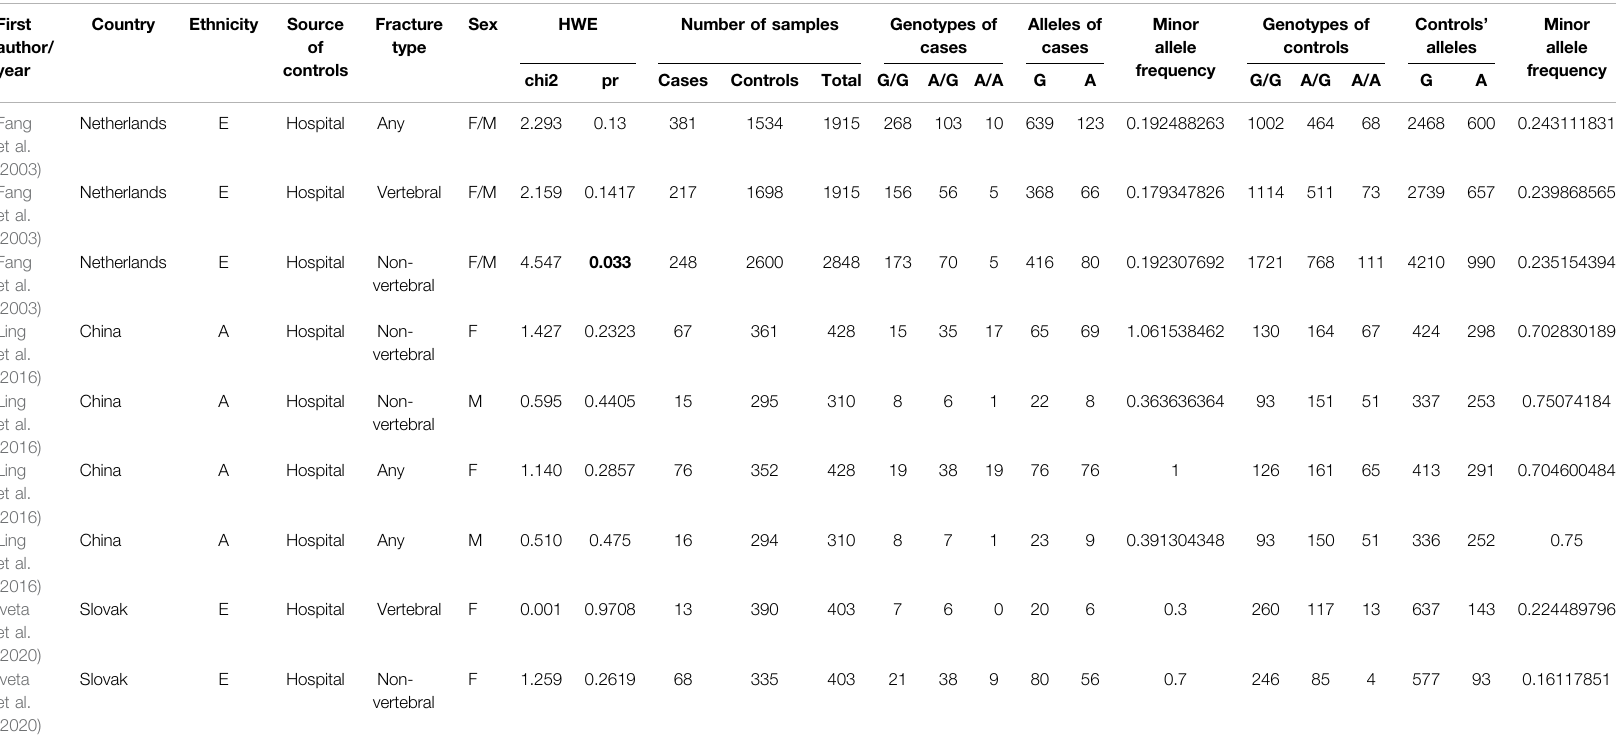
TABLE 6 | Genotype frequencies of VDR Cdx2 polymorphism in studies included in this